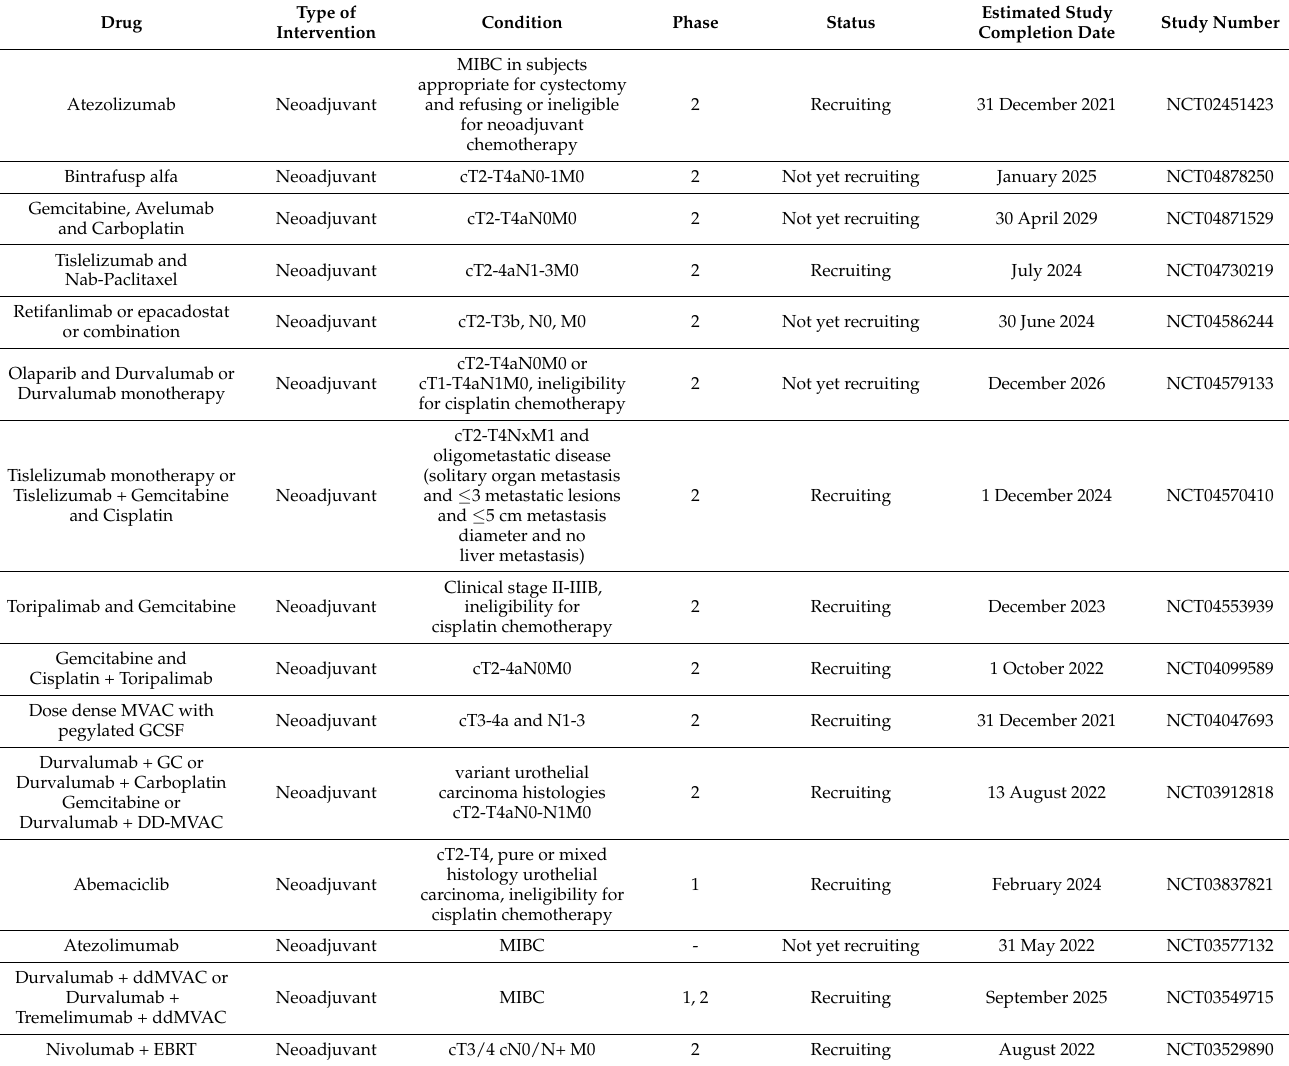
Table 2. Ongoing trials on perioperative (radical cystectomy) systemic